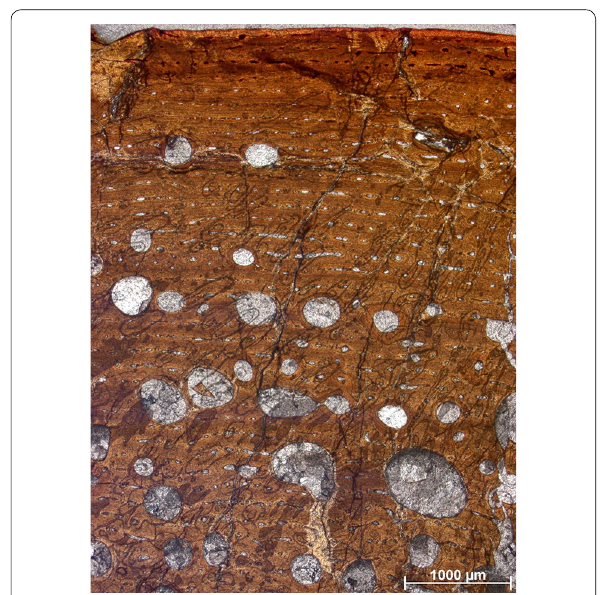
Fig. 14 Thin section of NMB M.H. 261 showing laminar fibrolamellar bone tissue with several secondary osteons and no clear lines of arrested